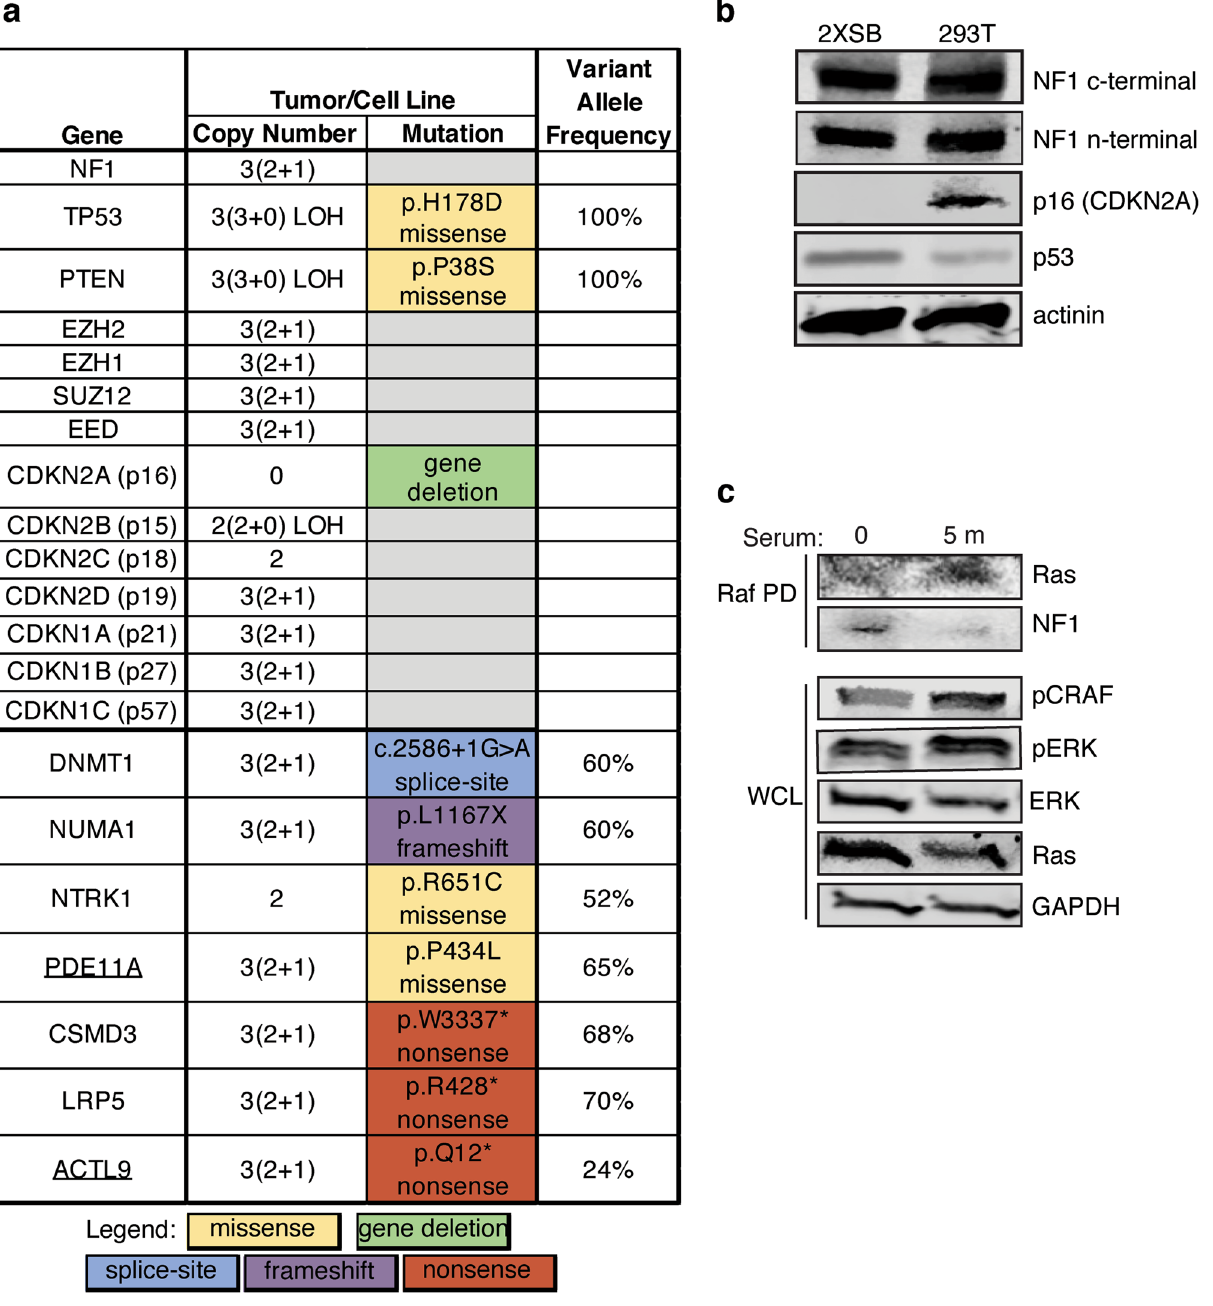
Figure 7. Mutational and functional status of key genes in 2XSB cells. ( a ) Summary of mutations identified by SNP array and/or WES sequencing analyses in genes previously implicated in MPNSTs and/or included in the Bushman Laboratory Cancer Gene List. Gene names that are underlined represent likely pathogenic calls and all others are pathogenic mutations. For copy number changes, the numbers in parentheses indicate the copy number of each haplotype, while the numbers outside the parentheses indicate the total copy number. If a mutation was not identified in a gene, the box in the mutation column is gray. ( b ) Immunoblot blot analysis of cell line-derived whole cell lysates from 2XSB cells and a control cell line (293 T). Lysates were prepared from 2D cultures of log phase cells and were probed with anti-C-terminal NF1, anti-N-terminal NF1, anti-CDKN2A (p16), and anti-p53 antibodies. Actinin was used as a loading control. ( c ) Ras activation assays were performed to determine the functional status of NF1 in serum deprived 2XSB cells stimulated with 10% serum for 5 min. Activated Ras was identified by Raf pull-down (Raf PD) with the Raf-Ras binding domain beads followed by immunoblotting with pan-Ras and NF1 antibodies. Activation of downstream effectors of Ras was determined in whole cell lysates by immunoblot analyses with anti-pCRAF and -pERK antibodies. Lysates were also probed with anti-total ERK and pan-Ras antibodies. GAPDH was used as a loading